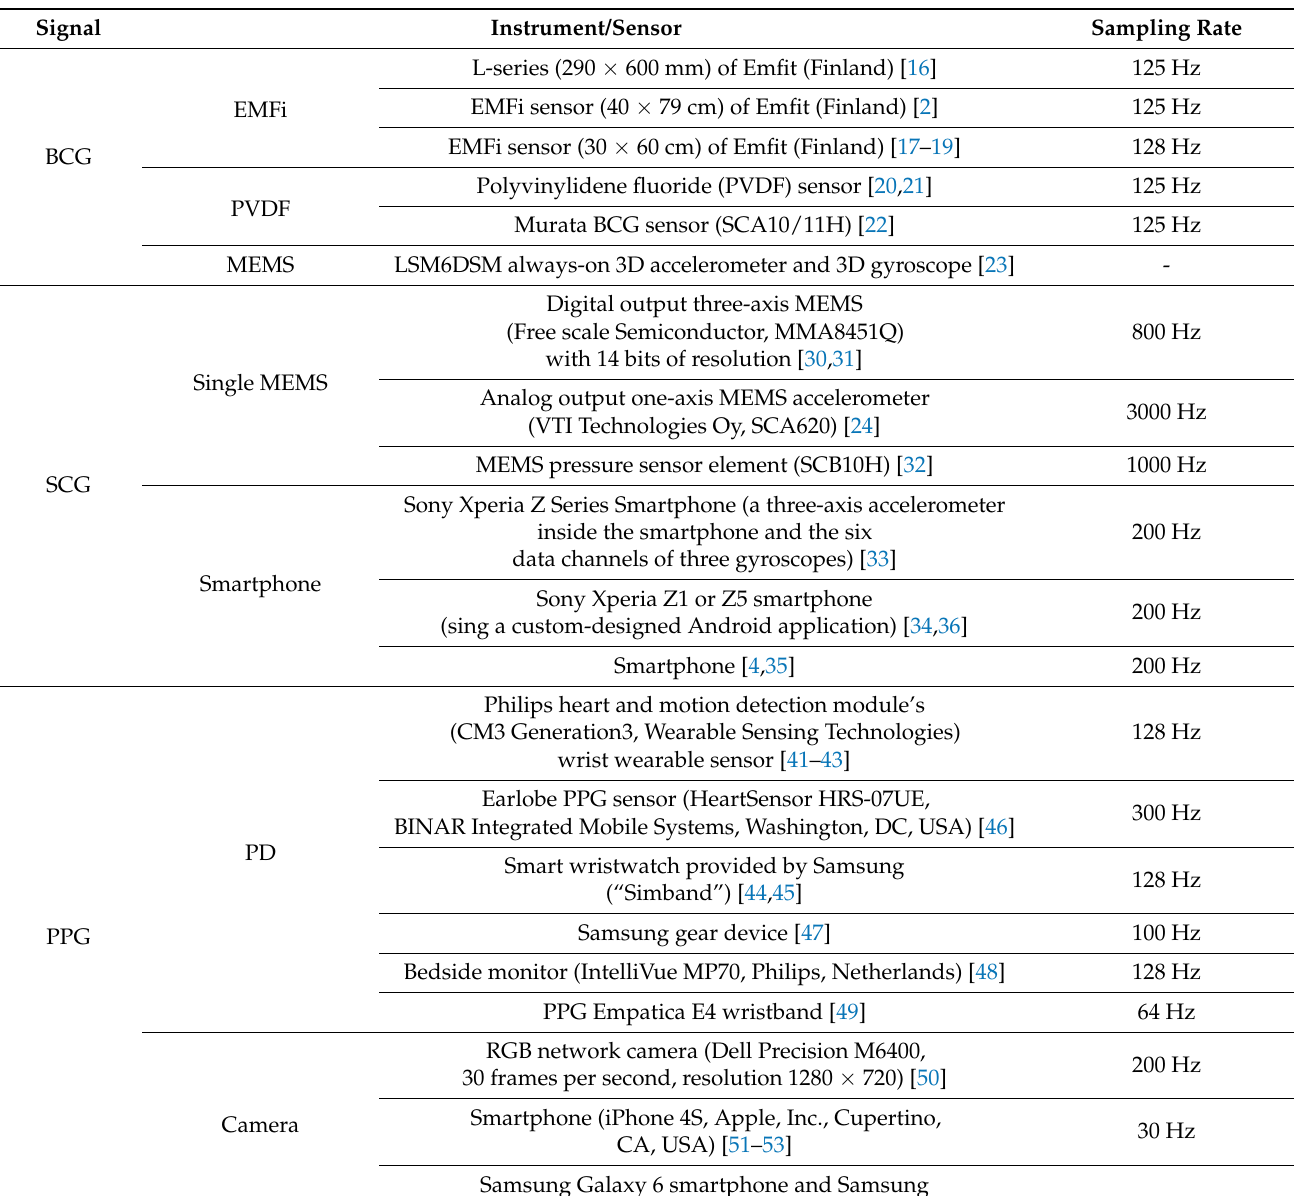
Table 1. Cardiac dynamics signals acquisition methods for AF